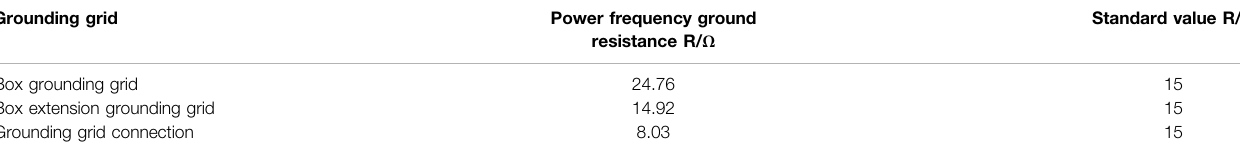
TABLE 1 | Grounding resistance of three grounding